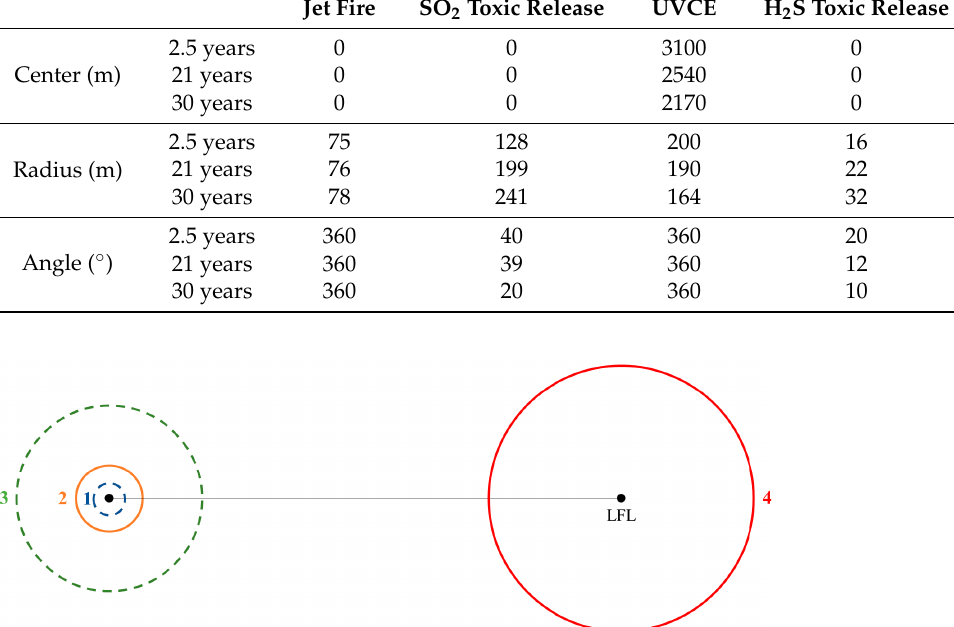
Figure 4. Example of the effect zones. The boundaries of the effect zones are named with numbers (1–4). Table 11. Total individual risk (IR) for each effect zone. The outcomes included in each effect zone are listed in the 2nd column.